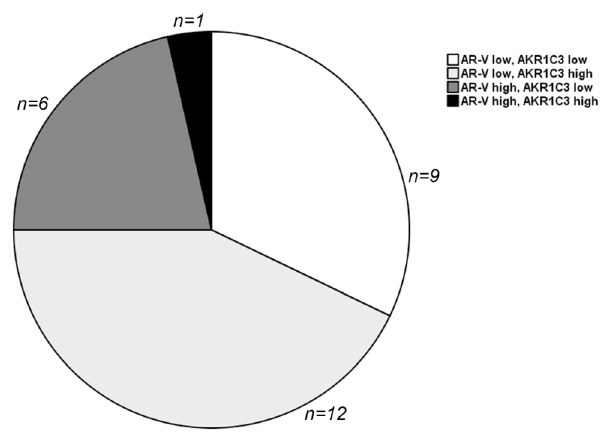
Figure 5. Characterization of 28 CRPC bone metastases according to protein levels of the steroidogenic enzyme AKR1C3 (defined as high if the AKR1C3 immunostaining score was above median, . 6, and low if the score was # 6) and protein levels of LBD-truncated AR variants (AR-Vs; defined as high if the ratio between the truncated 80 kDa and the full length 110 kDa AR bands was $ 0.5, quartile 4, and low if the ratio was below 0.5, quartile 1–3). High levels AKR1C3 were basically found in metastases with low levels of AR-Vs and vice versa (P=0.049, according to Chi-square